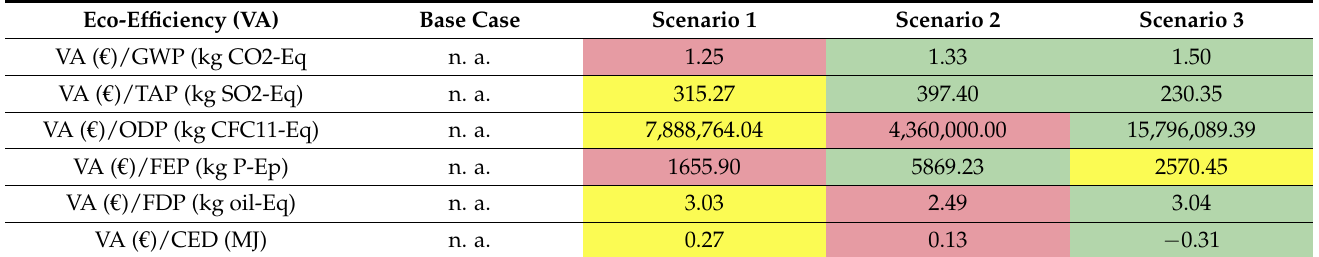
Table 6. Ranking of eco-efficiency (value added) performance of the different scenarios in the different impact categories (green = best to red =